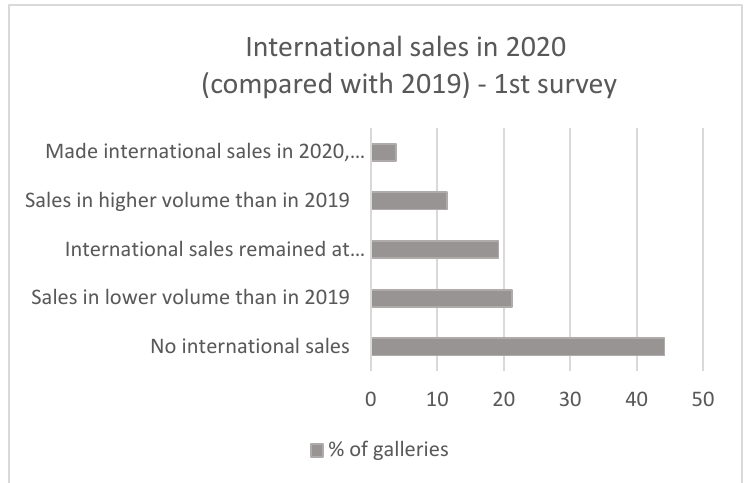
Figure 8. International sales—1st survey (January–September 2020). Data source: Author’s designed graphic, after Esmanhotto and Fialho (2020).